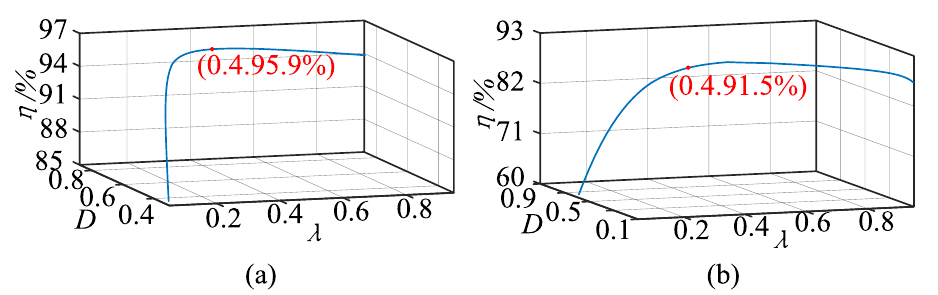
Figure 14. The calculation curve for λ, D , and the efficiency: ( a ) step-up mode, ( b ) step-down mode.